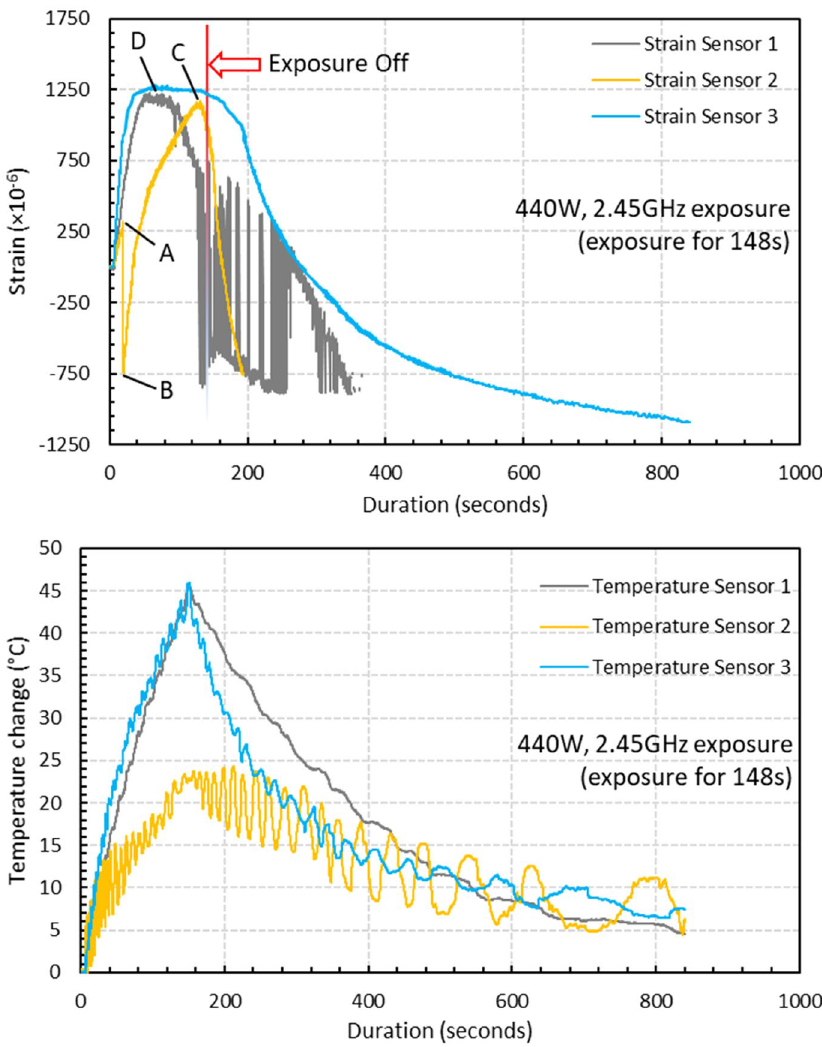
Figure 20. Strain and temperature change measurements of 15 wt.% silane-treated BaTiO 3 -Epoxy samples under 440 W for 148